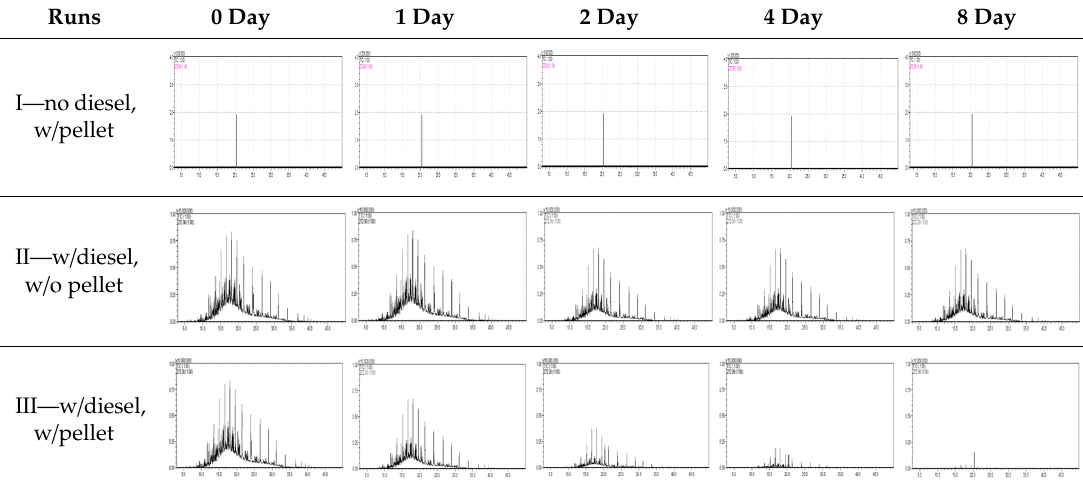
Table 2. Residual constituents of TPHd over time in the mimicked groundwater system at a depth of 10 cm.